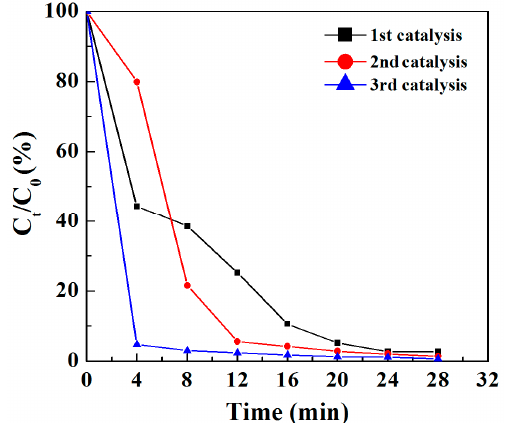
Figure 5. Residual fraction of chromium (VI) (Cr(VI)) versus time during the first, second, and third cycle of catalytic reaction using iron/palladium nanoparticle (Fe/Pd NP)-assembled filter paper.